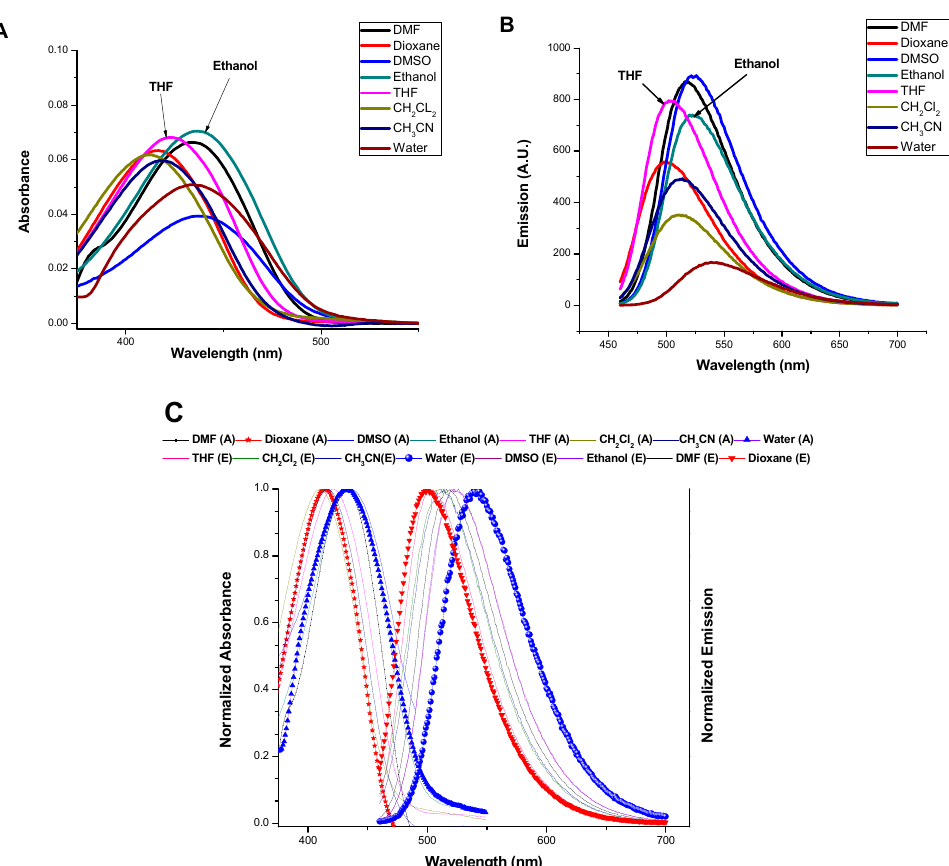
Figure 2. ( A ) Absorption spectra, ( B ) emission spectra, and ( C ) Normalized absorption and emission spectra of NI-DAT in various solvents. λ ex . = 450 nm.